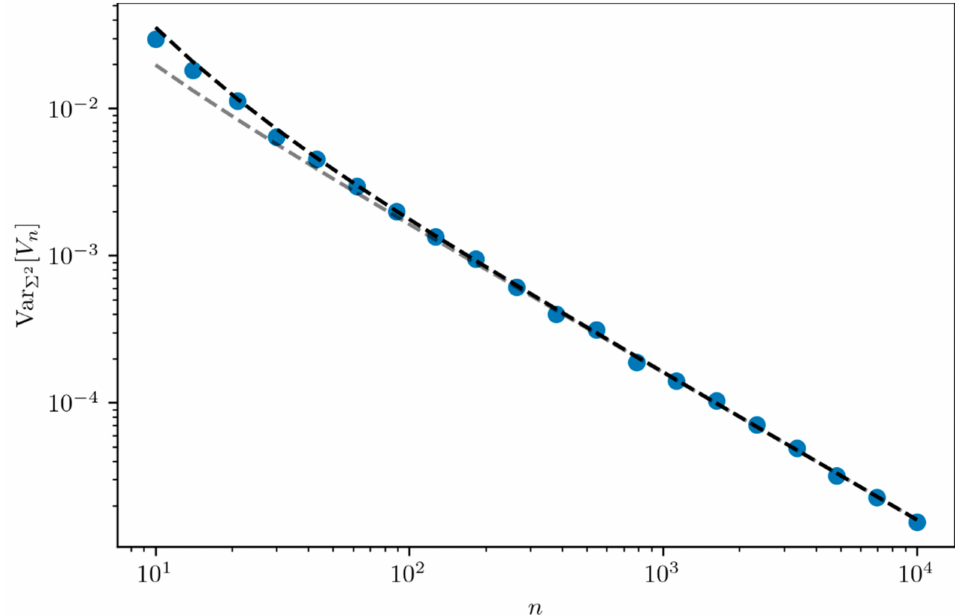
Figure 3. Evolution of the variance of V n for N = 2 as a function of the number n of players. The blue dots are simulated with Φ = 0.5 and Σ 2 = 0.15. The black dashed line corresponds to the variance of V n according to Equation (7). The grey dashed line corresponds to the leading-order term in 1/ n of the expected variance in Equation